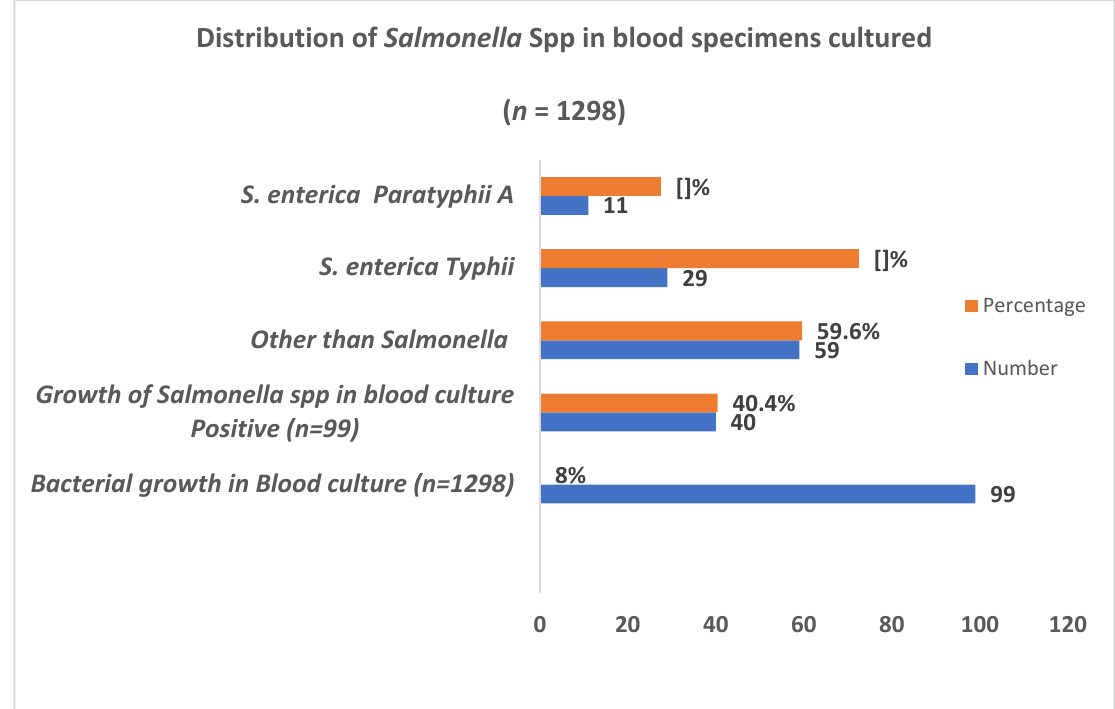
Figure 1. Distribution of Salmonella spp. in blood specimens cultured.